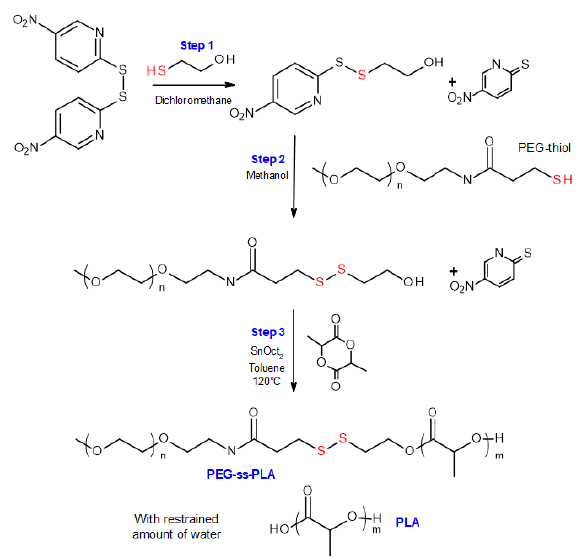
Figure 1. Synthesis scheme of the amphiphilic redox-responsive blends [19]. After the last step, corresponding to the polymerization of the lactide by ring-open- ing polymerization, two compounds are expected: mPEG-SS-PLA (P2a), polymerized from the hydroxyl functional group at the end of the modified PEG P1, and PLA (P2b), polymerized from traces of water. These three blends (abbreviated as B1, B2 and B3) differ in the length of the polymers which compose them as well as in the mass ratio between stimuli-sensitive polymer and conventional polymer (Table 1). For each blend, the poly- mer structure was confirmed by 1 H NMR, as demonstrated in Figure 2. Figure 2. 1 H NRM spectrum of blends 1, 2 and 3 (step 3, CDCl 3 , 25 °C).